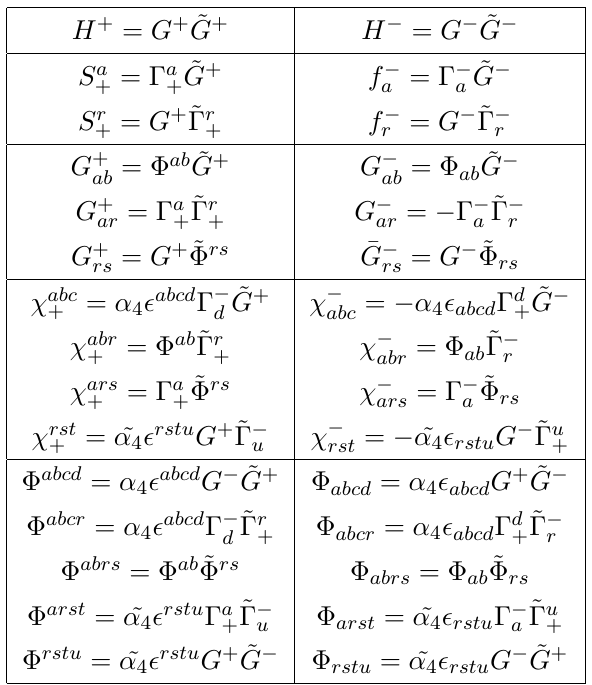
Table 3 . Factorisation of states in supergravity into states in super